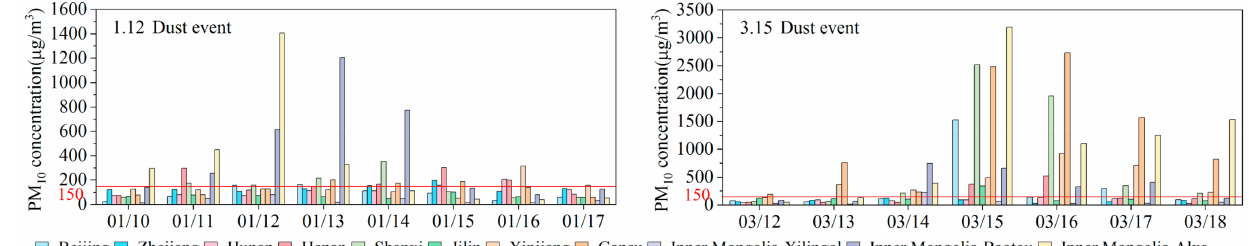
Figure 3. Daily average PM 10 values at ground stations during the 1.12 and 3.15